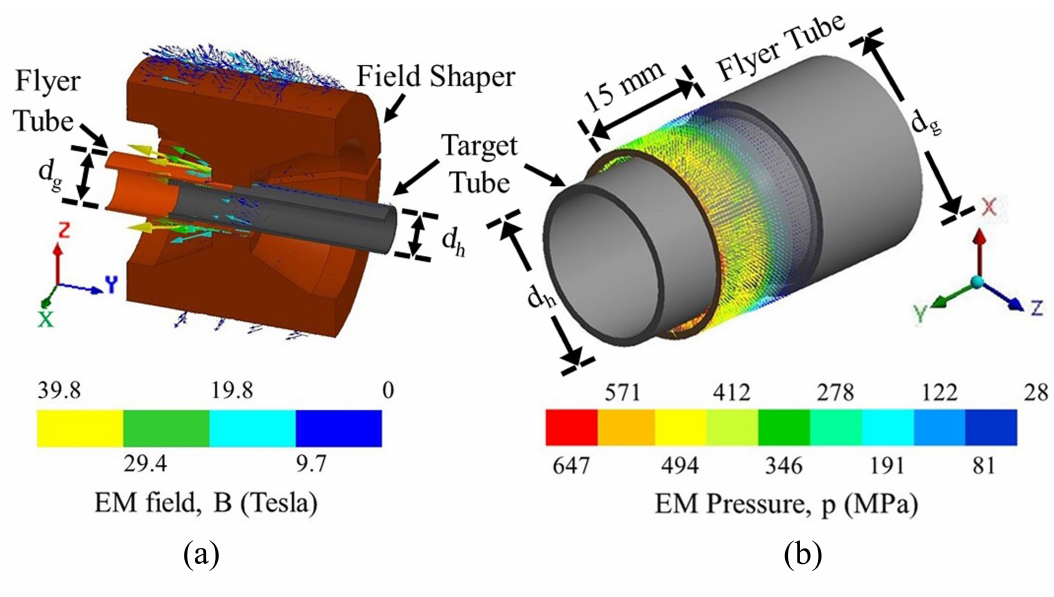
Figure 8. Numerically computed distribution of the maximum ( a ) EM field over the field shaper-tube assembly, and ( b ) EM pressure over the flyer tube for an applied energy of 14